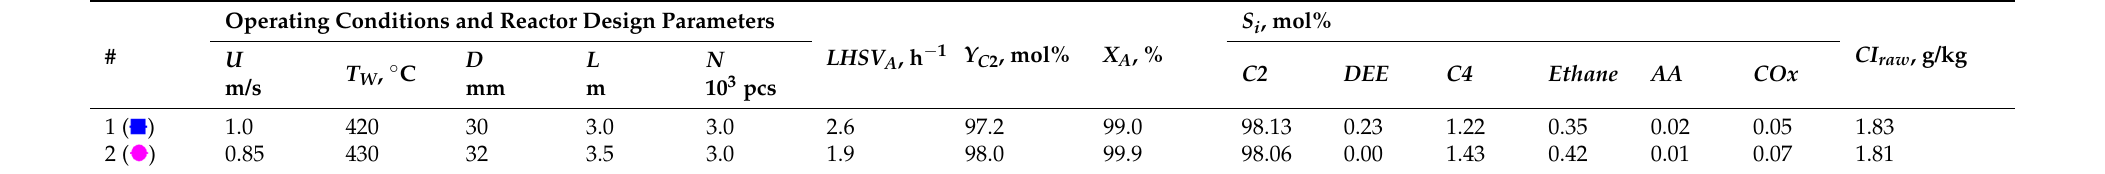
Table 3. Dehydration of pure 92% ethanol in MTR over proprietary 6mm ring-shaped alumina catalyst.